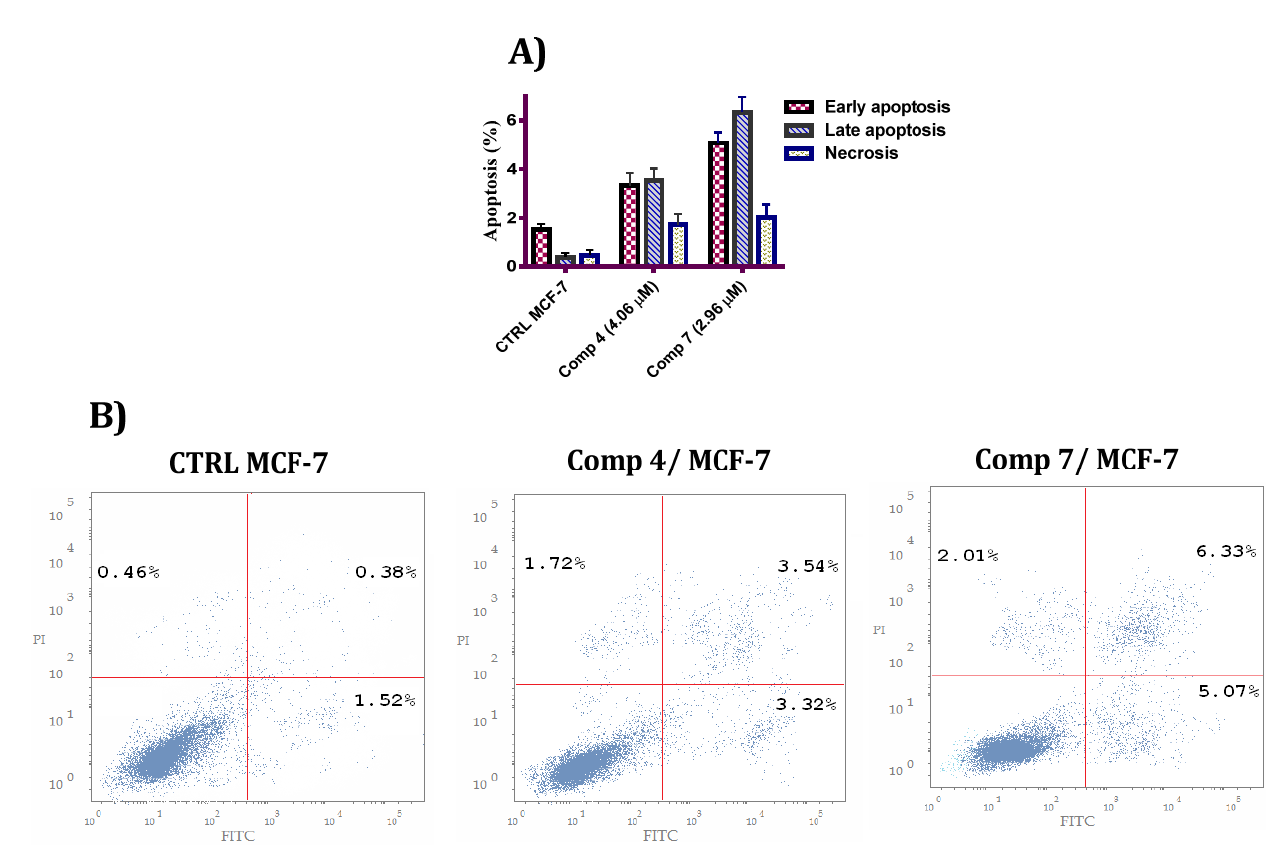
Figure 5. ( A ) The annexin V/PI study of compounds 4 and 7 compared with the untreated control. ( B ) Compounds 4 and 7 annexin V/PI analyses compared with untreated control.